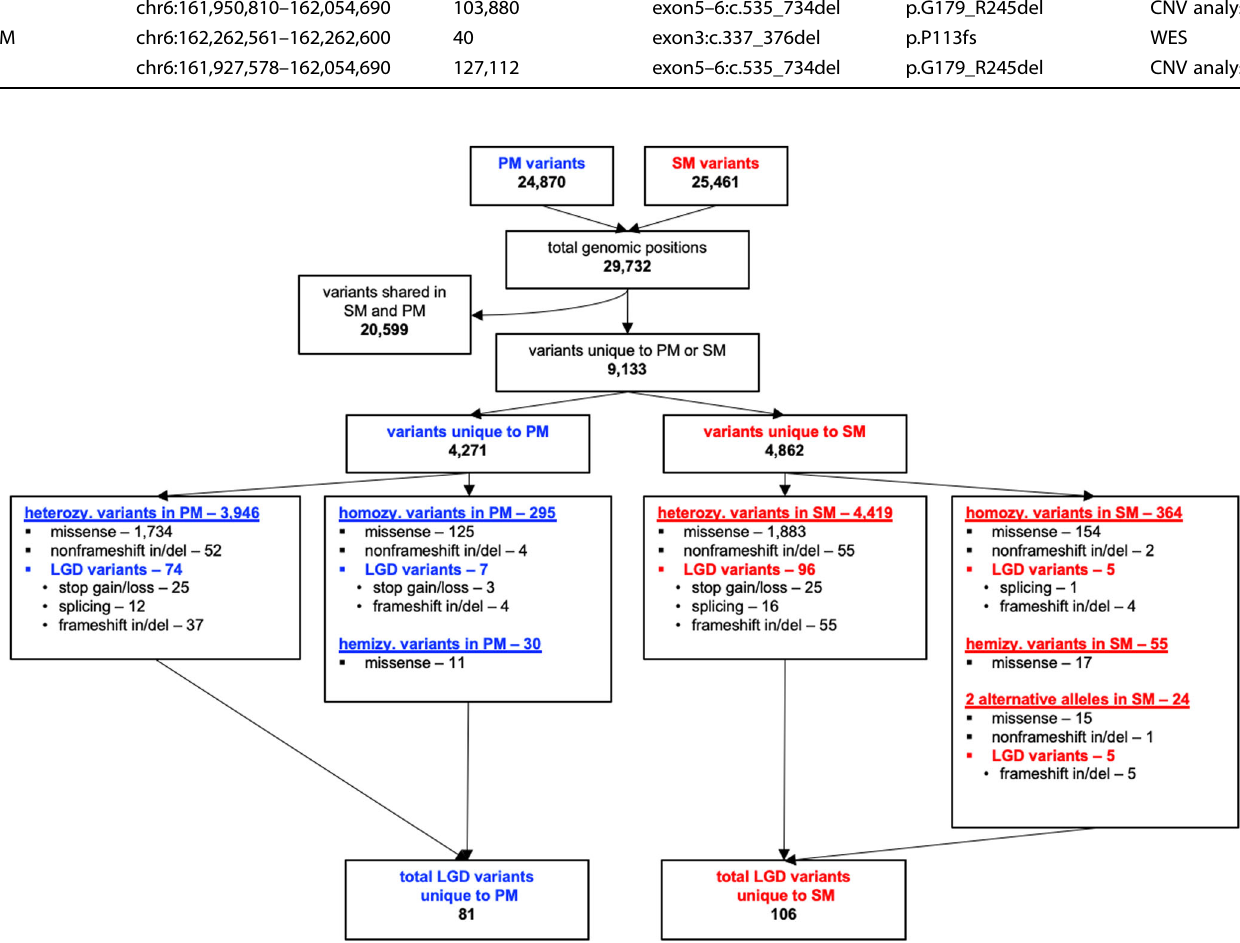
Fig. 2 Whole exome sequencing data prioritization overview. All variants detected for each of the siblings were compared and those unique to SM or PM further evaluated with regards to the type of mutation. The total number of variants that were likely gene disrupting (LGD) for SM (106) and PM (81) are indicated. (heterozy heterozygous, homozy homozygous, hemizy